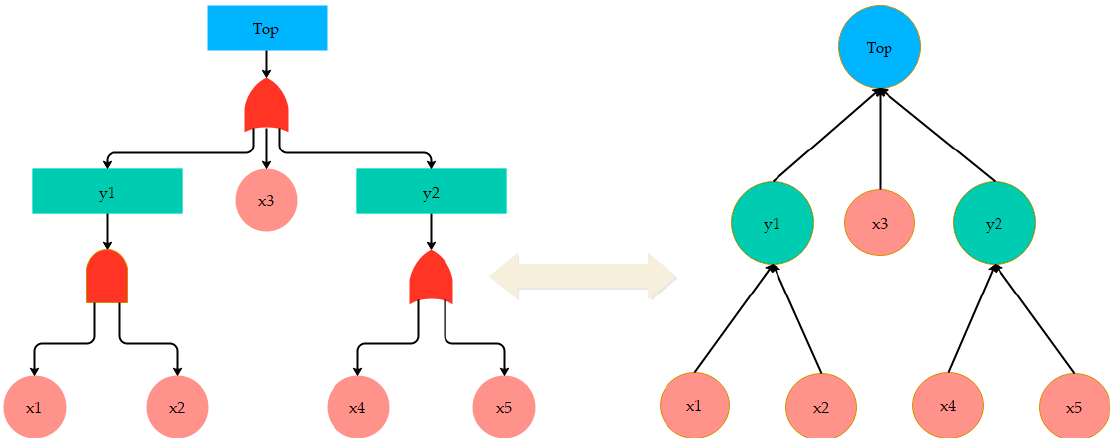
Figure 4. The corresponding expression graph between FFTA and Bayesian network graph.